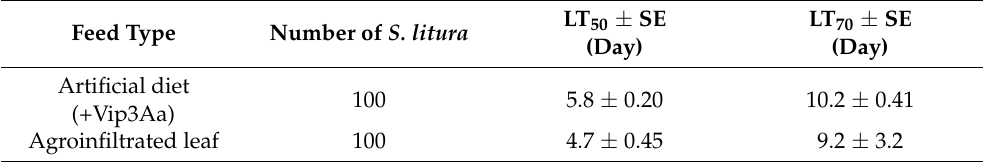
Table 1. The survival time of S. litura larvae using the insect